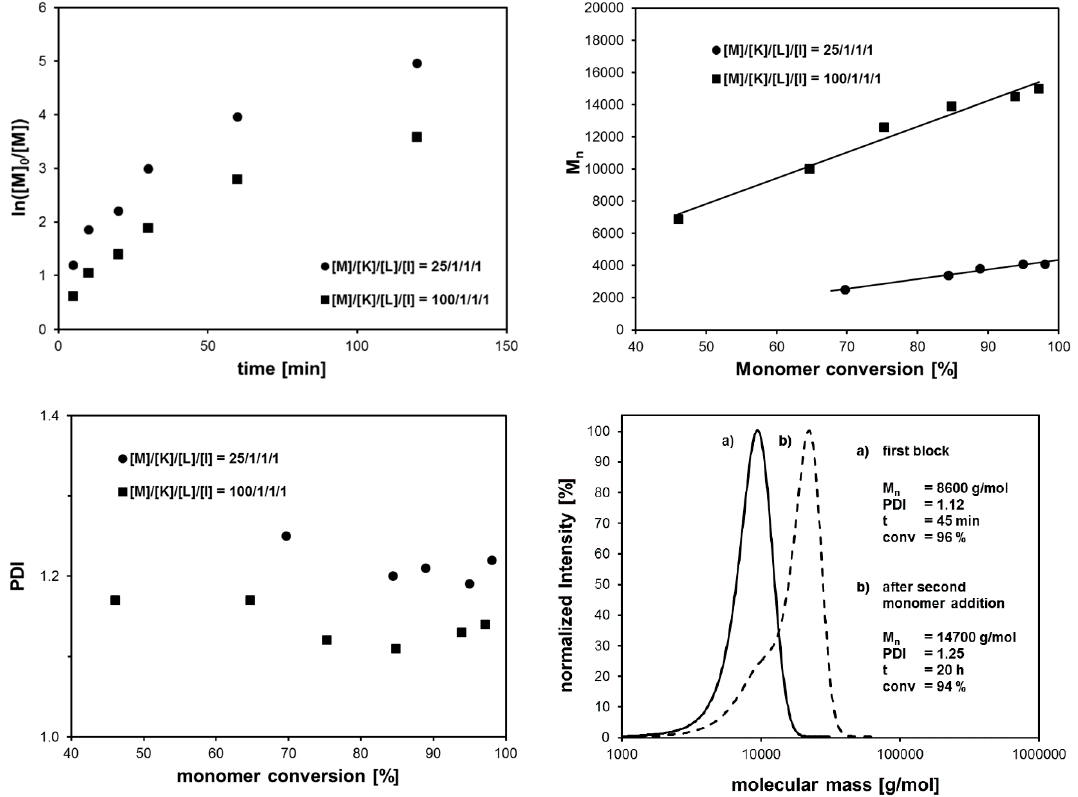
Figure 6. Polymerization kinetics and development of the number-average molecular mass and the polydispersity with increasing monomer conversion and molecular mass distributions (SEC) in the self-blocking experiment.